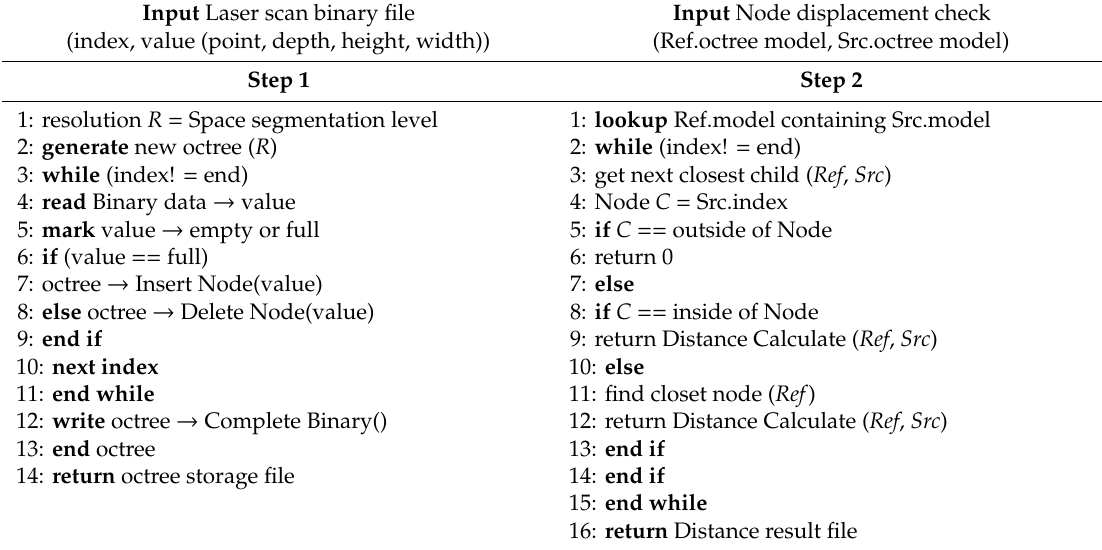
Table 5. Octree spatial division and node displacement